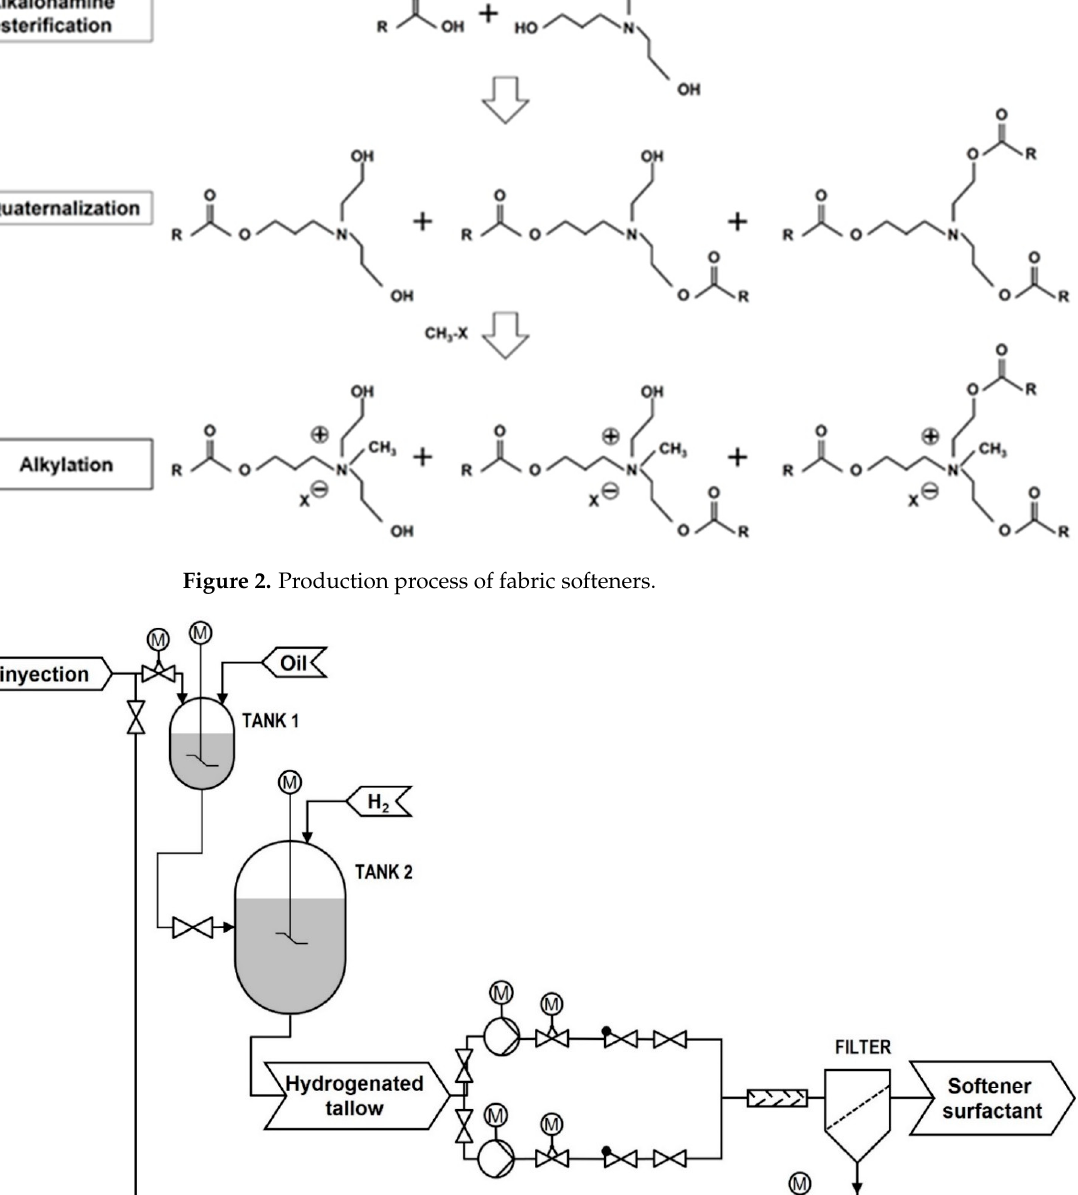
Figure 3. Experiment for determining the MI.